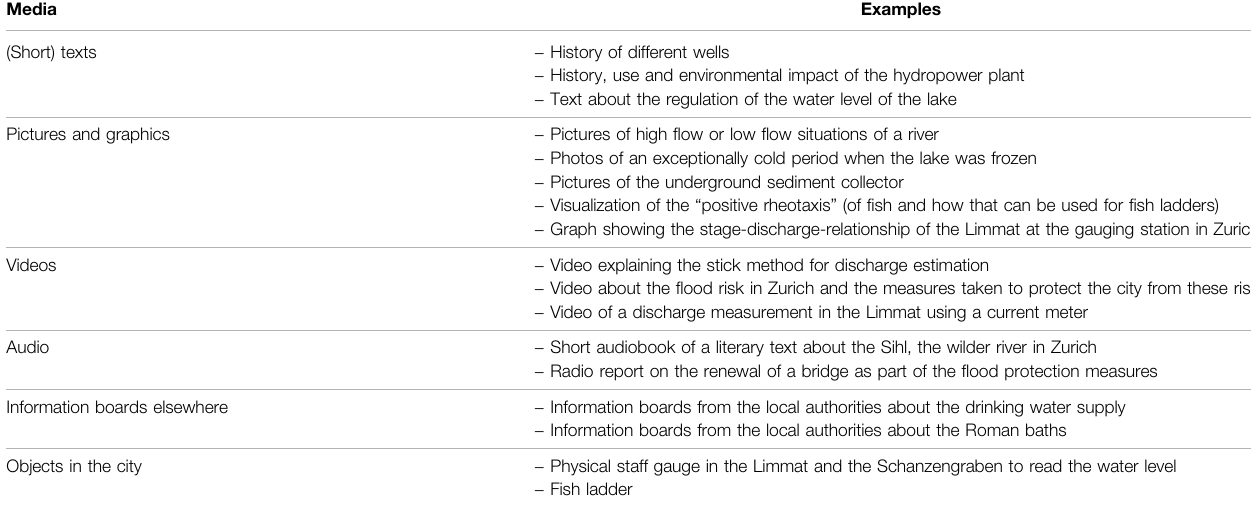
TABLE 2 | Media types that can be used in the excursion and examples from the Water in the city of Zurich excursion.